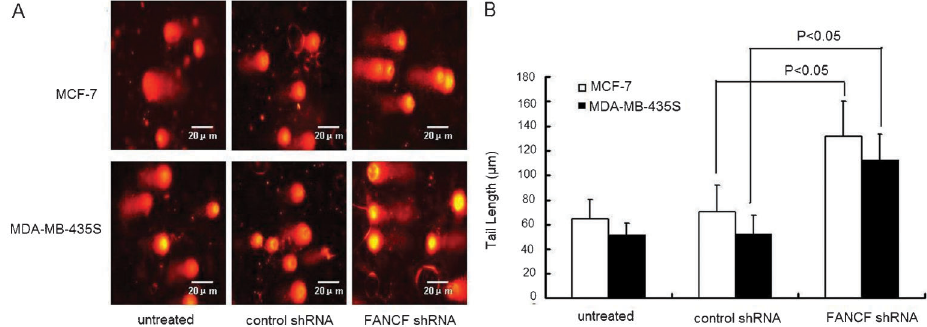
Figure 8. FANCF silencing increased Dox-induced DNA damage in MCF-7 and MDA-MB-435S breast cancer cells. A , Forty-eight hours after transfection, cells were treated with 10 nM Dox for 24 h and examined by single-cell gel electrophoresis (comet assay), which showed increased DNA damage in the form of DNA fragmentation visualized under a fluorescence microscope. B , Quantification of tail lengths ( m m) of the comet from 30 comets for each group. Data are reported as means±SD of three independent experiments in triplicate. ANOVA followed by the post hoc test was used for statistical